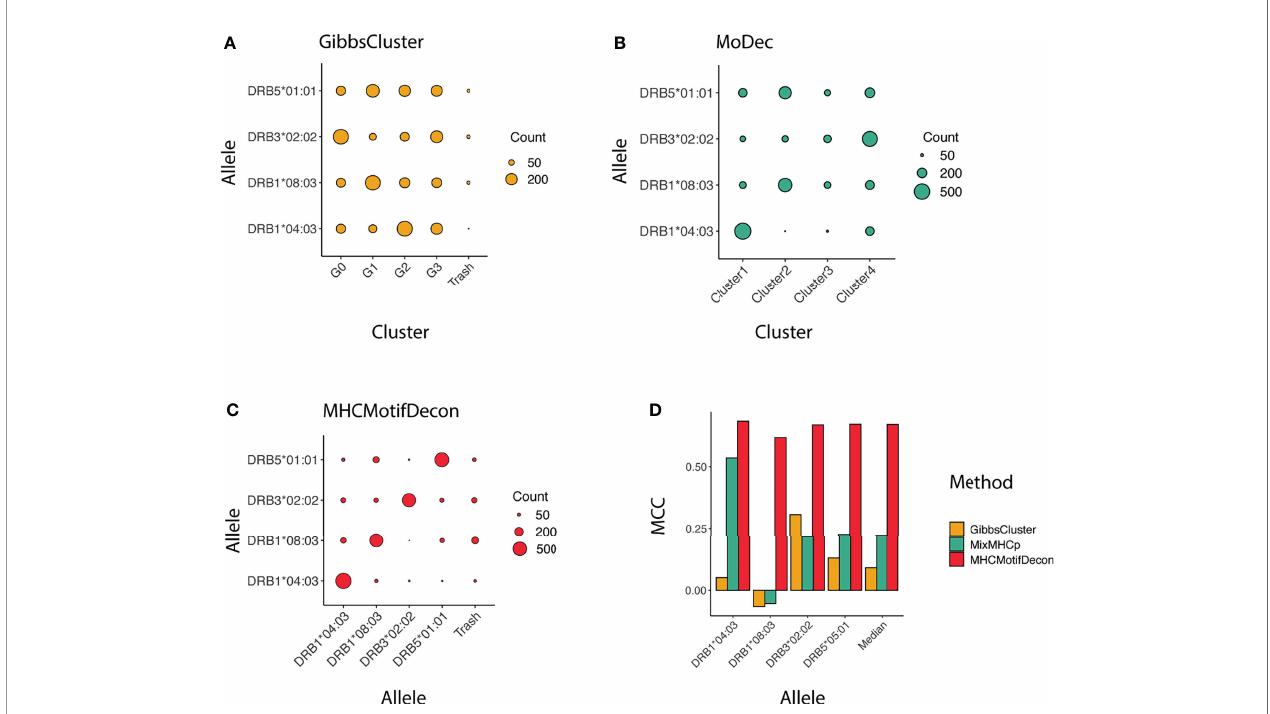
FIGURE 4 | Clustering confusion matrix and Matthews correlation performance for the three methods (A) GibbsCluster, (B) MoDec and (C) MHCMotifDecon. (D) Matthews correlation (MCC) performance estimates of accuracy of the motif deconvolution of the different methods for the arti fi cial MS HLA eluted ligand dataset. MCC values for each method and HLA were estimated from the confusion matrices and cluster-HLA annotations shown in Figure 3